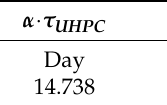
Table 2. Regressed parameter value after model modification.